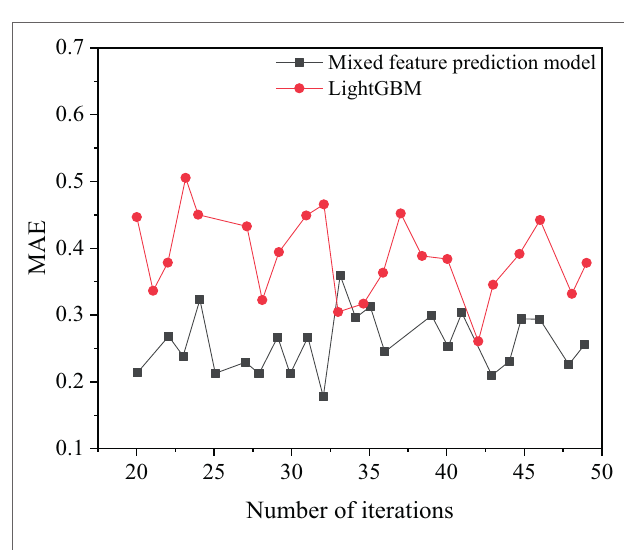
FIGURE 14 | MAE results compared with LightGBM.